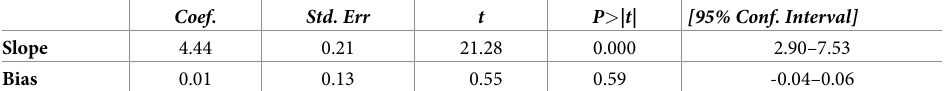
The pooled estimated mean difference in MPV. For each study, the mean difference in MPV between IBD and control was estimated. The pooled estimated SMD was -0.83fl; 95% CI: -1.15,-0.51; p < 0.001 (Fig 5). The finding was suggesting as the pooled average MPV in IBD patients was 0.83fl lower than the average pooled MPV of healthy controls. Since this pooling was extremely heterogeneous (I 2 = 93.1%; p < 0.001) and so population based sub-group anal- ysis was used to investigate potential sources of heterogeneity. The highest estimated mean dif- ference in MPV and significant heterogeneity were observed among patients of CD; SMD =